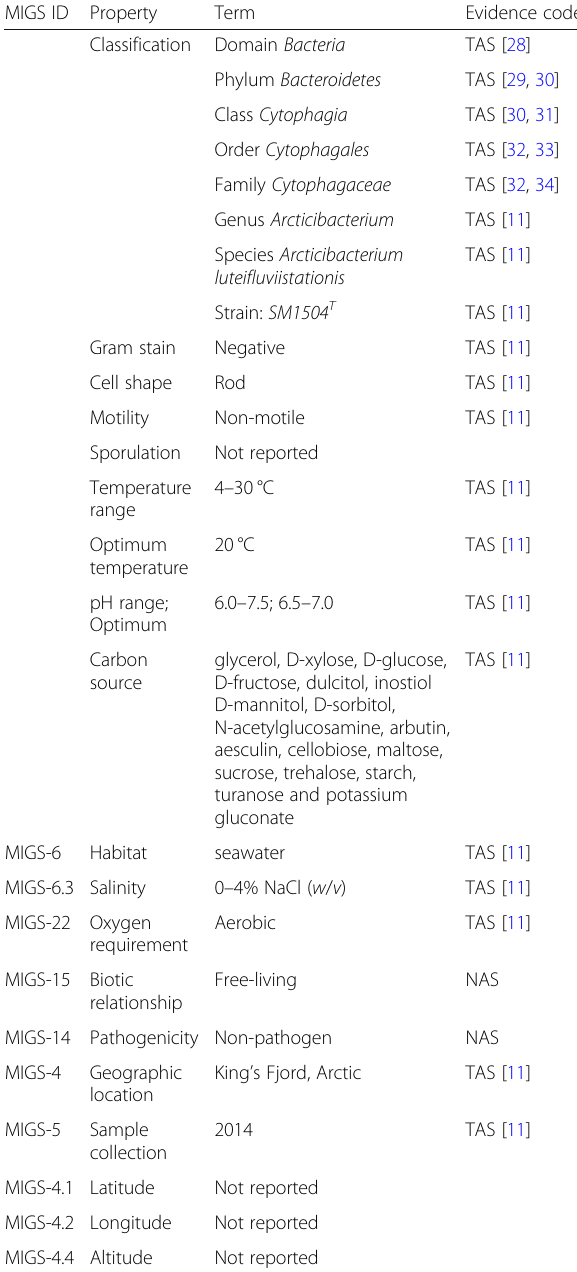
Table 1 Classification and general features of Arcticibacterium luteifluviistationis SM1504 T